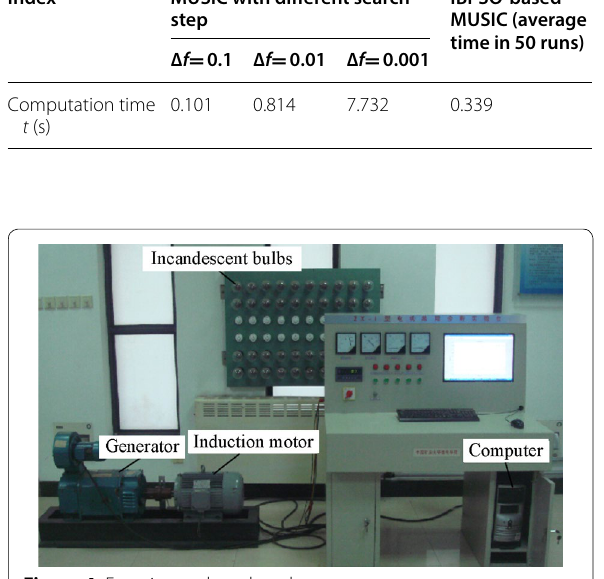
Figure 4 Experimental test bench